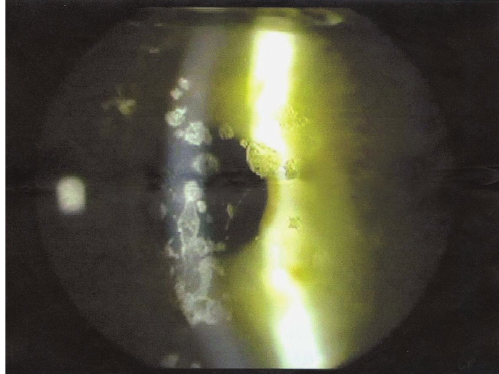
Figure 2: A digitalized picture of the right eye, taken before LASIK was performed, shows the presence of multiple crumb-like and lattice-like stromal opacities consistent with the diagnosis of ACD. No granular infiltrates were present before